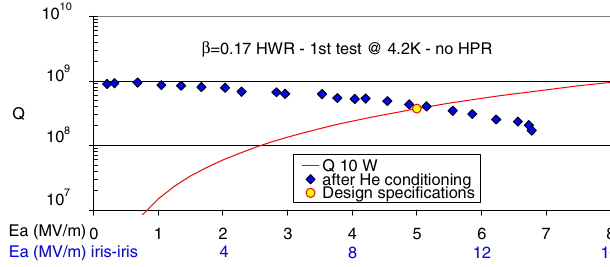
FIG. 7. (Color) Low- (cid:1) HWR performance at 4.2 K. Active length 180 mm (90 mm with the Spoke definition, corresponding to the gradient E a iris - iris